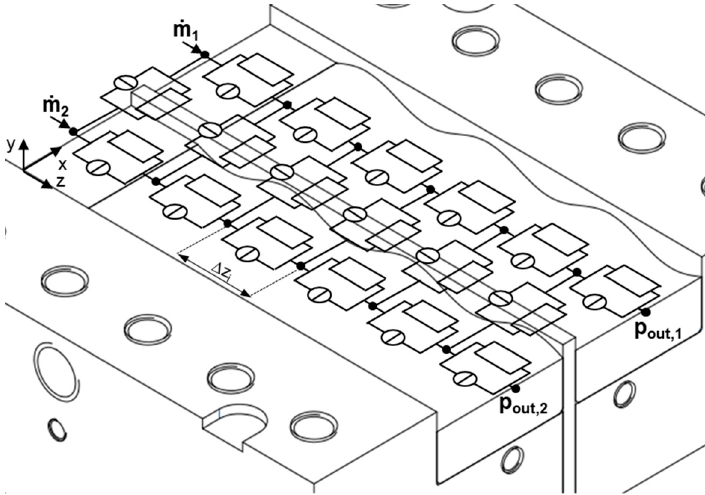
Figure 8. Flow network of a dual wave section, consisting of down- and cross-channel elements. The mass flow rates at the inlets are ṁ 1 and ṁ 2 , and the pressures at the outlets are p out,1 and p out,2 .